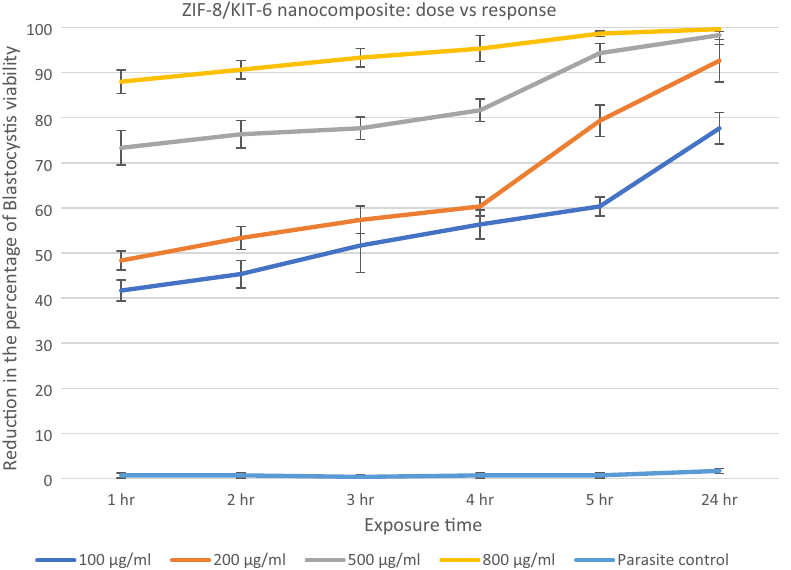
Figure 8. Reduction in the percentage of blastocystosis cysts viability after exposure to increasing concentrations of ZIF-8/KIT-6